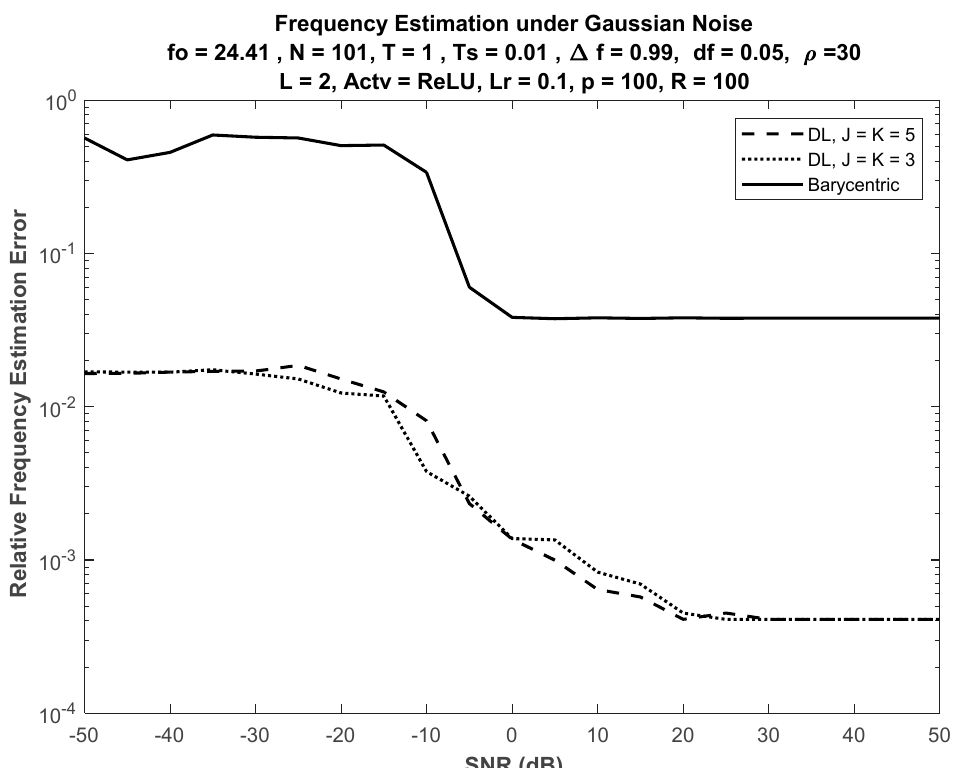
Figure 7. Performance of DL-based FE under different sizes of hidden layers. No significant difference in DL performance between networks with sizes J = K = 5 and J = K = 3 .